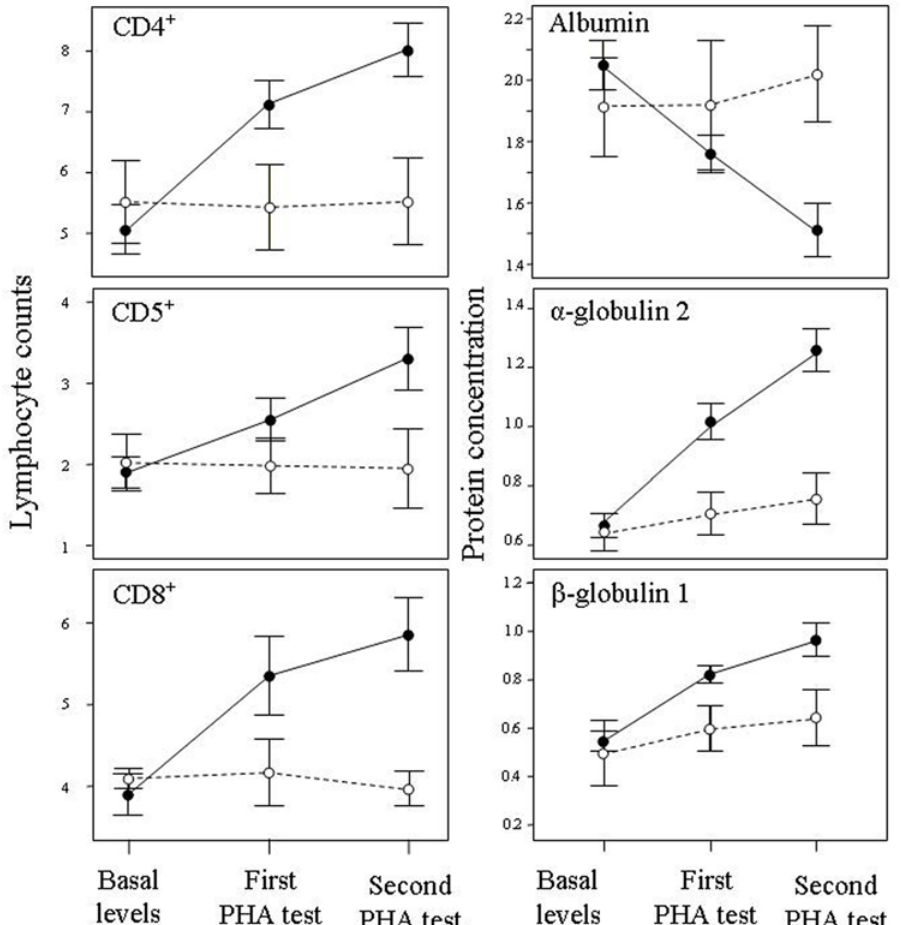
Figure 2. Changes in counts of lymphocyte subsets and protein concentrations ( m g/L) in the bloodstream from basal levels to those resulting 24 h after a first and a second PHA injection. Black dots represent experimental birds (injected with PHA) and white dots represent control birds (injected with PBS).